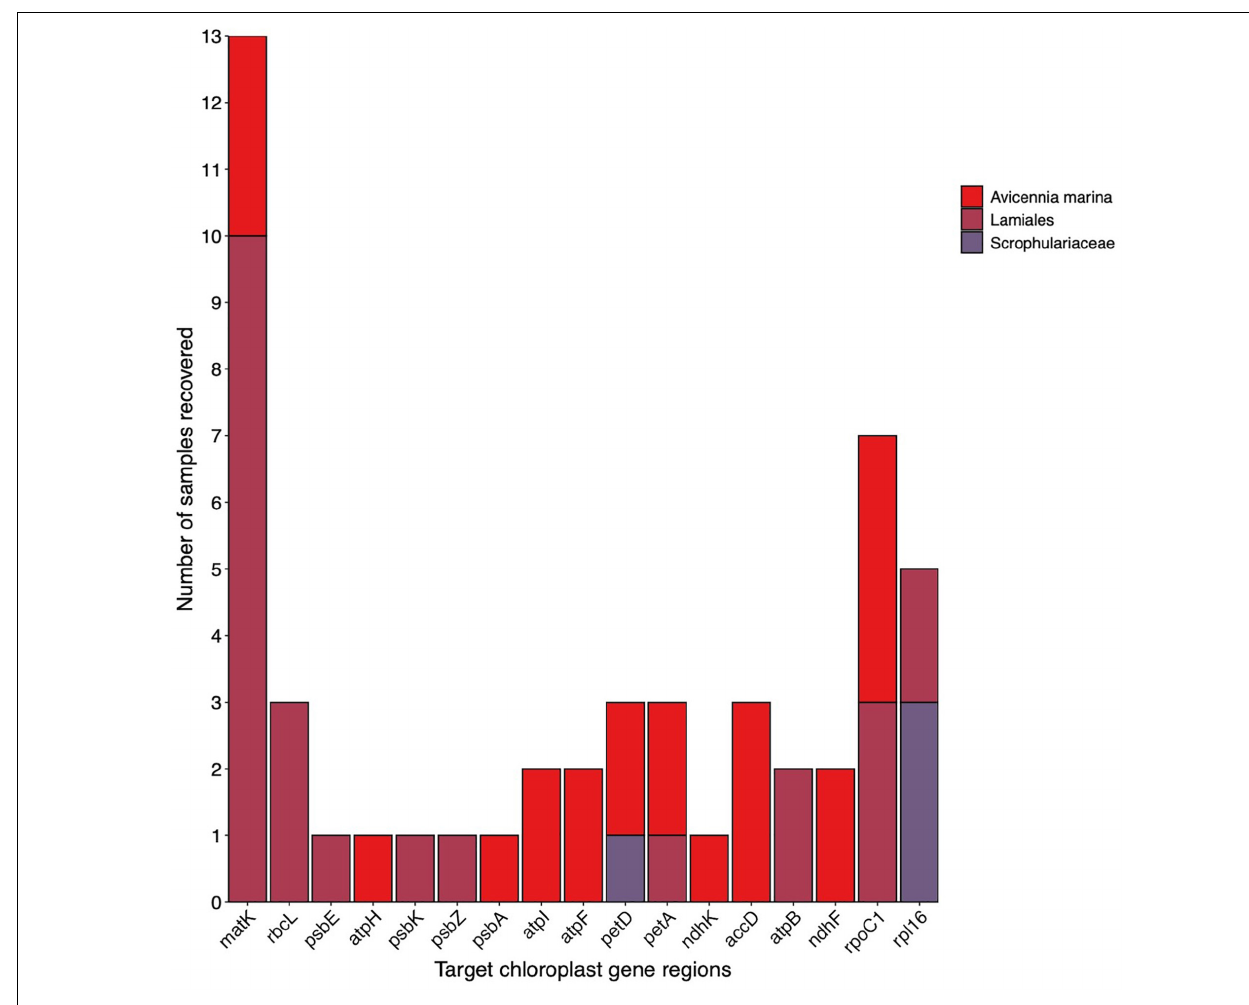
FIGURE 4 | Target chloroplast gene region recovery for plant taxa detected in an unknown sediment sample. Colours indicate level of taxonomic classification. Multiples of the same gene region recovered for A. marina indicate multiple samples in the reference library were